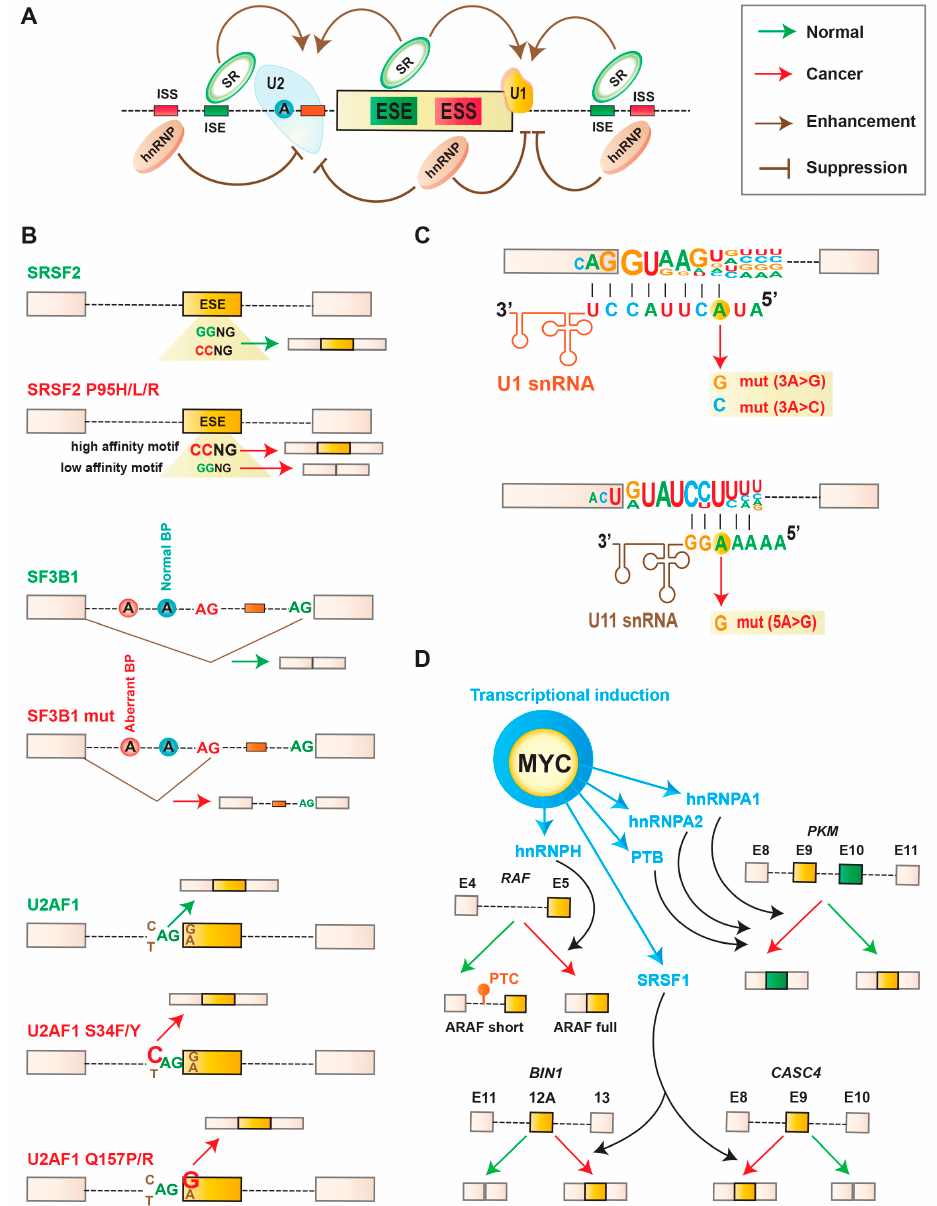
Figure 1. Splicing alterations in cancer. ( A ) Schematic of splicing regulatory cis -elements, which can influence alternative splicing regulation. Based on location and functional activity, these elements can be categorized into intronic / exonic splicing enhancers (ISEs / ESEs) and intronic / exonic splicing silencers (ISSs / ESSs). Exon inclusion or skipping is regulated by binding of cognate splicing trans -factors, such as serine / arginine (SR) proteins and heterogeneous nuclear ribonucleoproteins (hnRNPs). ( B ) Mechanistic consequences of cancer-associated recurrent mutations in spliceosomal genes SRSF2 , SF3B1 , and U2AF1 . Mutations in Pro95 of SRSF2 changes its RNA-binding specificity from a G-rich motif (GGWG, W = A/U) to a C-rich motif ((C/G)CWG). Mutations in SF3B1 alter 3 ′ splice site by enhancing recognition of cryptic upstream 3 ′ splice sites. Mutations in U2AF1 alter 3 ′ splice site consensus sequences. Wild-type U2AF1 recognizes the consensus motif yAG|r at the intron–exon boundary (y = pyrimidine, r = purine, ‘|’ = intron–exon boundary). S34F or S34Y mutations promote recognition of cAG | r over tAG | r, whereas Q157P or Q157R mutations promote recognition of yAG | g over yAG | a. ( C ) Cancer-associated mutations in U1 small nuclear RNA (snRNA) and U11 snRNA. ( D ) Mechanistic consequences for abnormal expression of splicing-factor in cancer. MYC increases